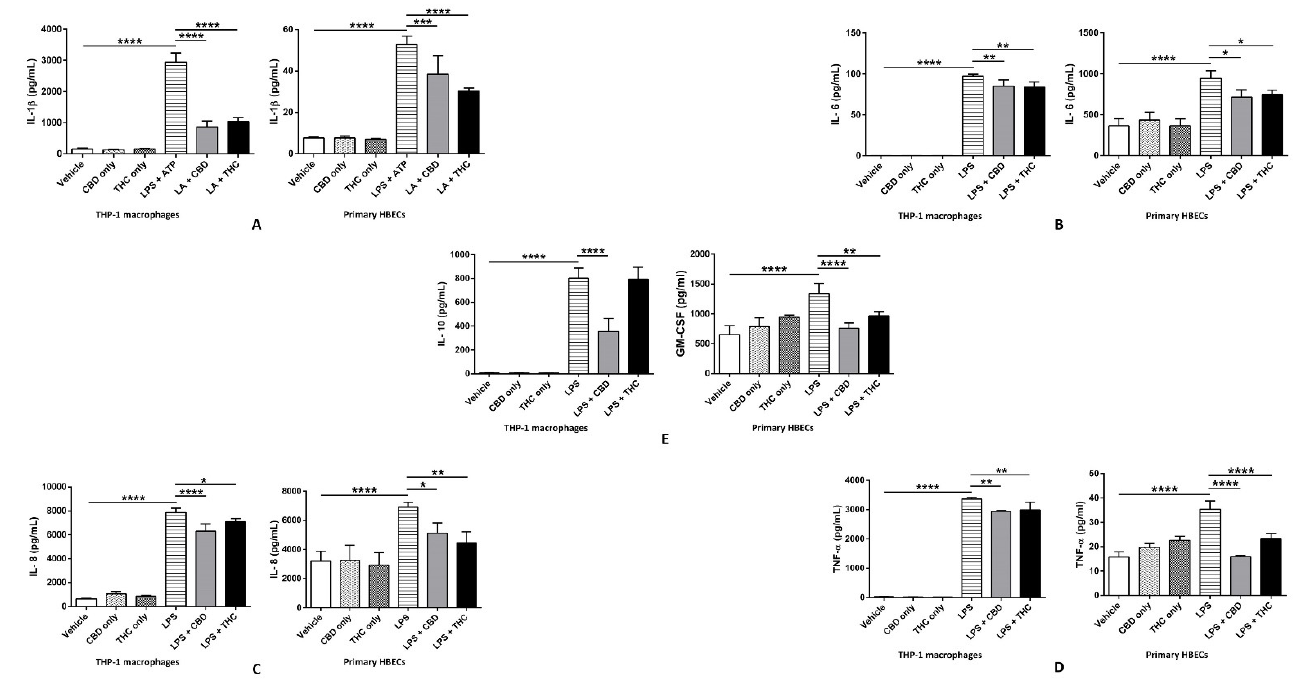
Figure 4. Effect of cannabinoids on the levels of cytokines in THP-1 macrophages and primary human bronchial epithelial cells. ( A ): CBD and THC decreased the levels of IL-1 β after LPS + ATP stimulation in THP-1 macrophages and primary HBECs: The levels of released IL-1 β in the cell supernatants were measured using ELISA kit (R&D systems) and quantified using one-way ANOVA with Tukey’s multiple-comparison test. Four independent experiments ( n = 4) from THP-1 and primary human bronchial epithelial cell supernatants obtained after pre-treatment with CBD or THC for 30 min